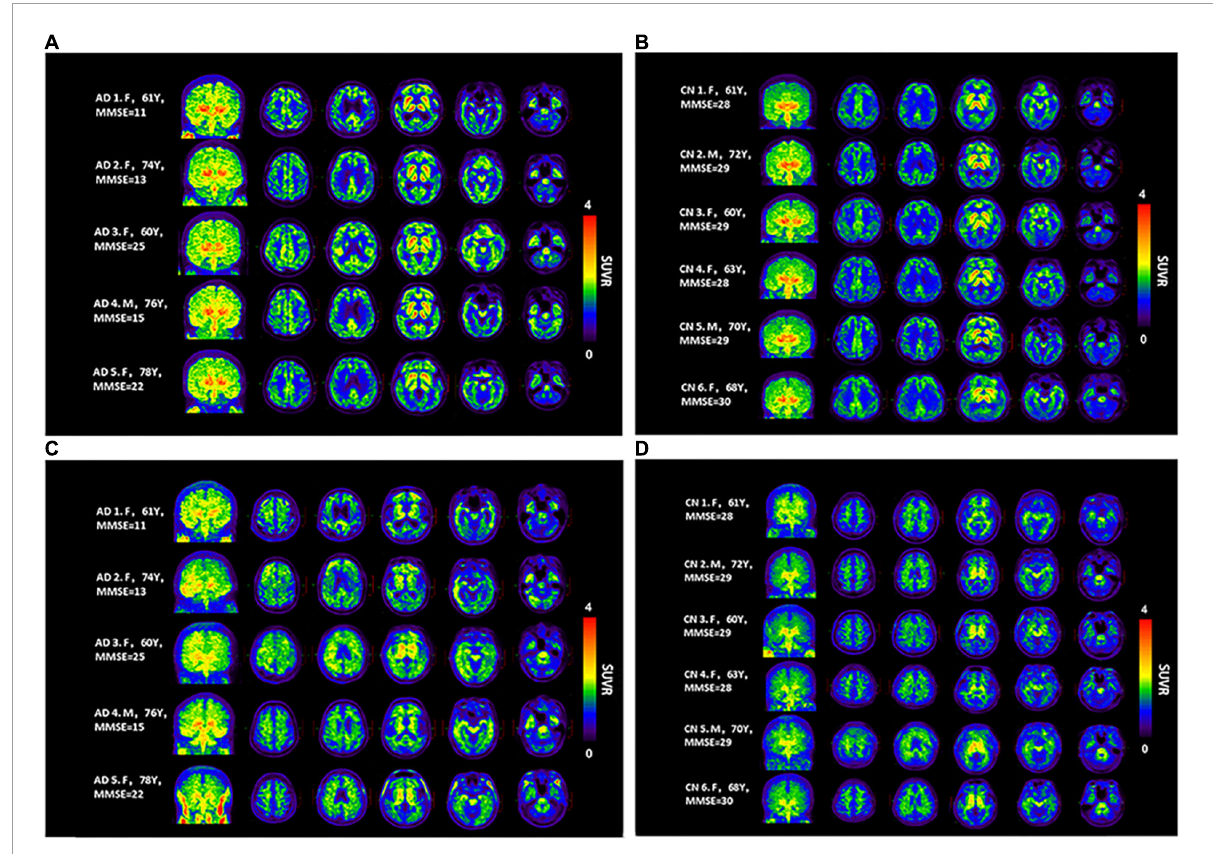
FIGURE2 Maximum intensity projection (MIP) and axial [ 18 F]-S16 (A,B) and [ 18 F]-THK5317 (C,D) positron emission tomography images (40–60 min) for all Alzheimer’s disease patients (AD subjects 1–5) and healthy controls (HCs subjects 1–6). From the left to the right panels, the transverse PET images correspond to the levels at the centrum semiovale, PCC, basal ganglia, hippocampus, and basal temporal cortex, respectively.